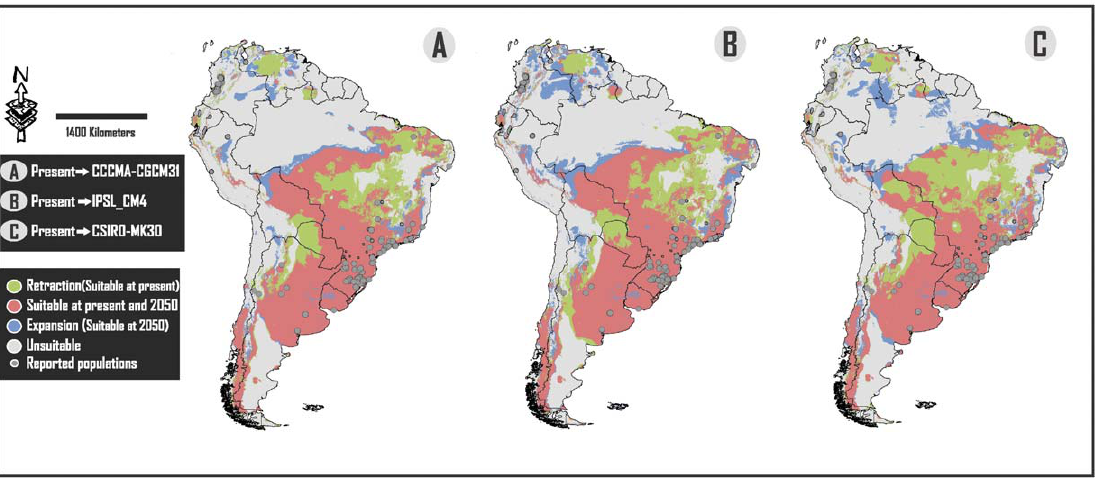
Figure 2. Comparison between results of projections at present and 2050. Each map shows potential suitable areas for Lithobates catesbeianus at one of the three different analyzed AOGCMs, classified in: Retraction (suitable areas at present but not at 2050), Expansion (suitable areas at 2050 but not at present conditions) and suitable areas at present and at 2050.